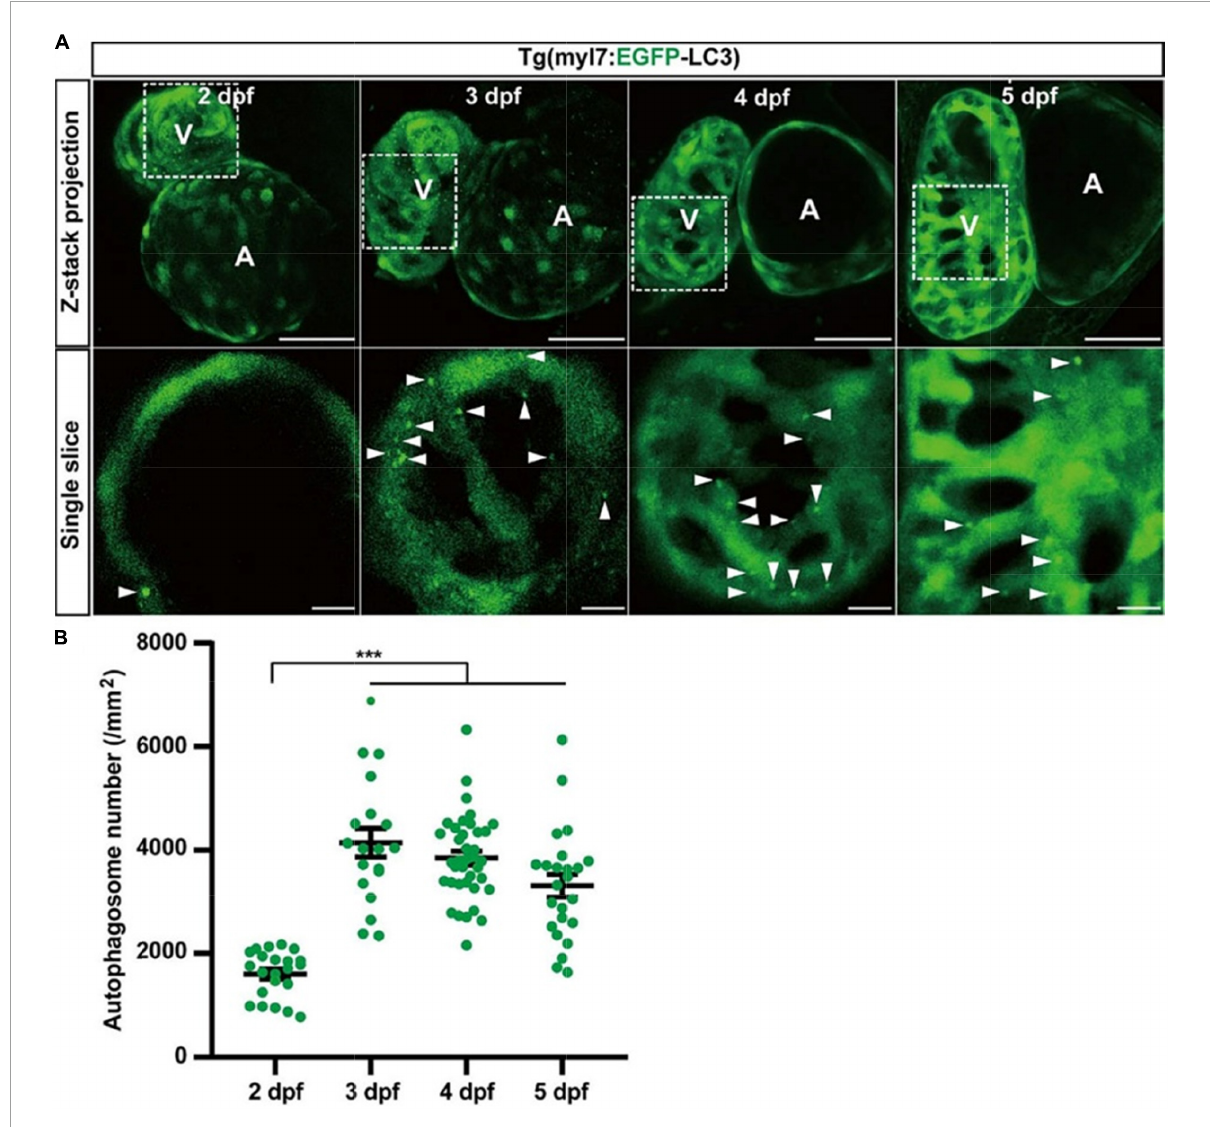
FIGURE3 The density of autophagosomes in zebrafish cardiomyocytes is quantified during 2–5 dpf. (A) Representative images of zebrafish heart of Tg(myl7:EGFP-LC3) line at indicated developmental stages. Top row shows the Z-stack maximum projections (scale bar: 50 µ m), and the bottom row shows the single slice (scale bar: 10 µ m). Arrowhead represents the autophagosome. (B) Quantification of the density of autophagosomes in zebrafish cardiomyocytes of indicated developmental stages. The data are shown as mean ± s.e.m for each group. n = 22 at 2 dpf, n = 19 at 3 dpf, n = 38 at 4 dpf, and n = 24 at 5 dpf. *** p < 0.001. A, atrium; V,